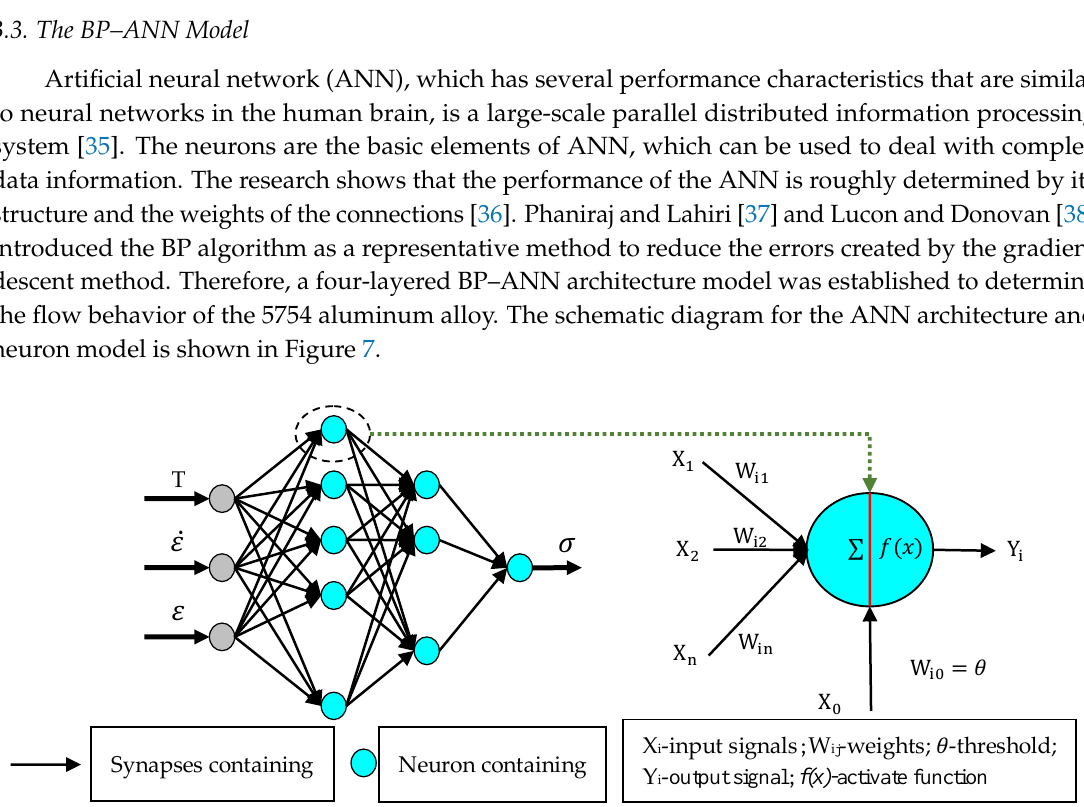
Figure 6. The variation in true deformation temperature according to true strain at the pre-set deformation temperatures of ( a ) 300 °C, ( b ) 400 °C, and ( c ) 500 °C; ( d ) the corrected flow curves with preset deformation temperature and a strain rate of 10 s −1 .